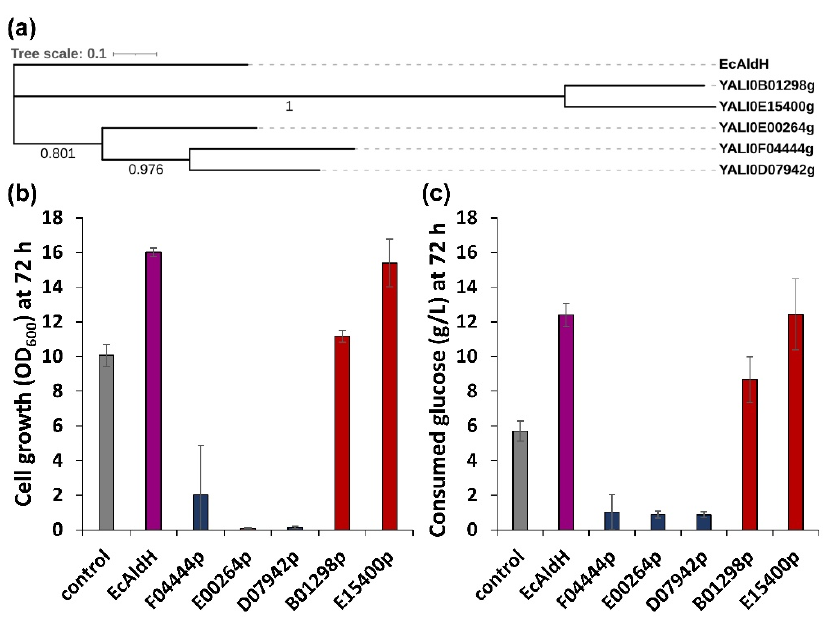
Figure 3. Comparison of the sequence similarities of the endogenous ALDHs, and the effect on the furfural tolerance in Y. lipolytica . ( a ) Phylogenetic tree of aldehyde dehydrogenases used in this experiment. Cell growth ( b ) and glucose consumption ( c ) of Y. lipolytica overexpressing various aldehyde dehydrogenases in the presence of 0.4 g/L furfural. Table 1. Description of the aldehyde dehydrogenases used in this study.